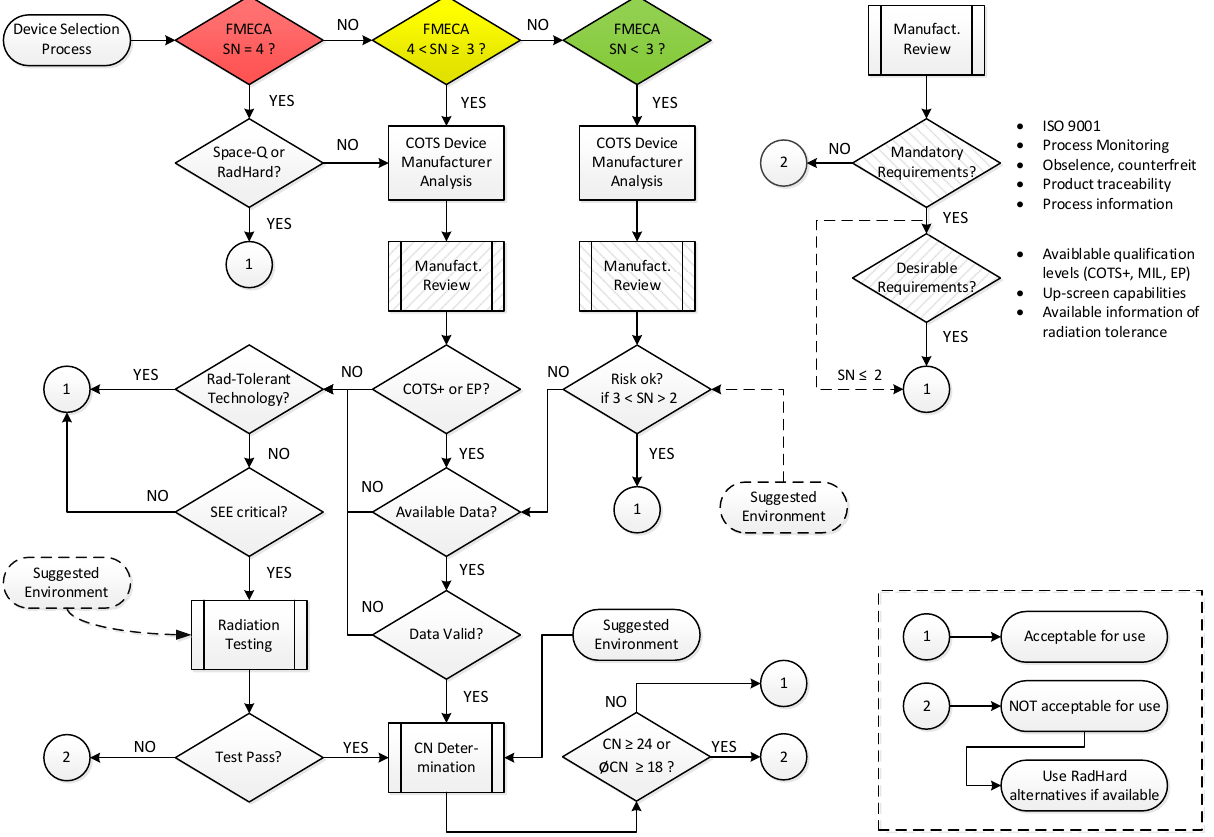
Figure 7. EEE component evaluation and guidance flow chart.